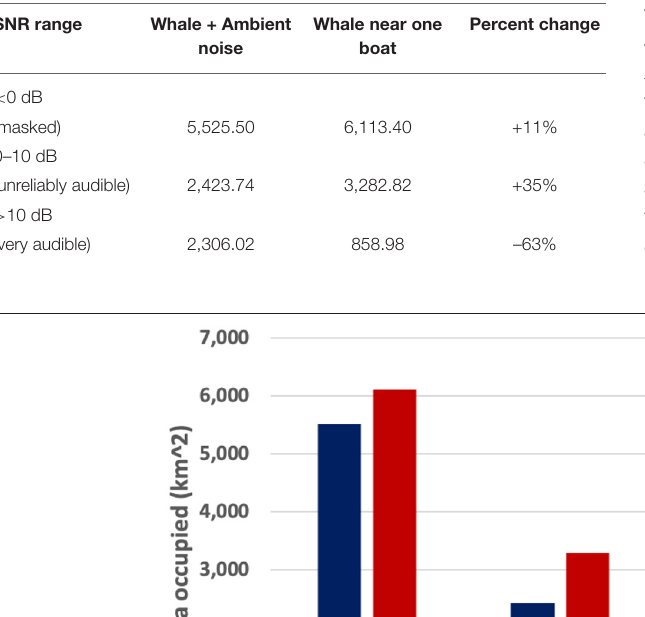
TABLE 2 | Area (km 2 ) that three SNR-binned audibility ranges occupy within the simulation for the September 5, 2019, scenario #1 (single whale alone with just ambient noise vs. single whale in close proximity to a single boat plus ambient noise).